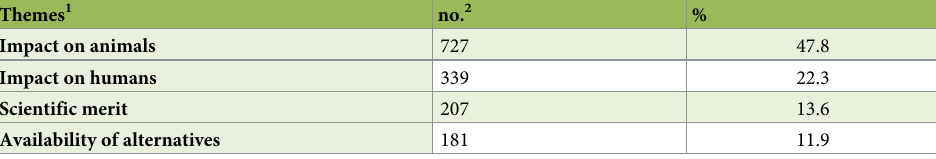
Table 2. Themes present in participant ( n = 1521) reasoning regarding their support for five different research protocols, together with the number of participants (expressed both as a whole number and as a percentage of the sample) who expressed this